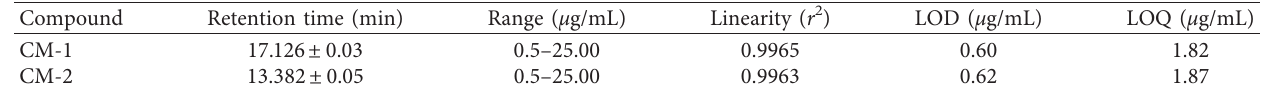
Figure 5: HPLC chromatograms of standard of two furanodiene compounds. Table 1: Calibration parameters and sensitivity data for two compounds using the proposed HPLC method.